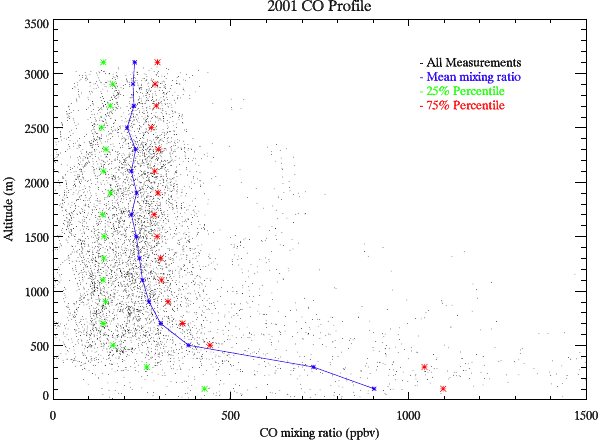
Fig. 9. Lumped long-term annual mean tropospheric ozone column abundances in the lowest 1500m. The size of each circle is pro- portional to the number of research spirals for a specific summer. Blue and Red circles show the mean column ozone in upwind and downwind regions, respectively. The green line shows the differ- ence between upwind and downwind